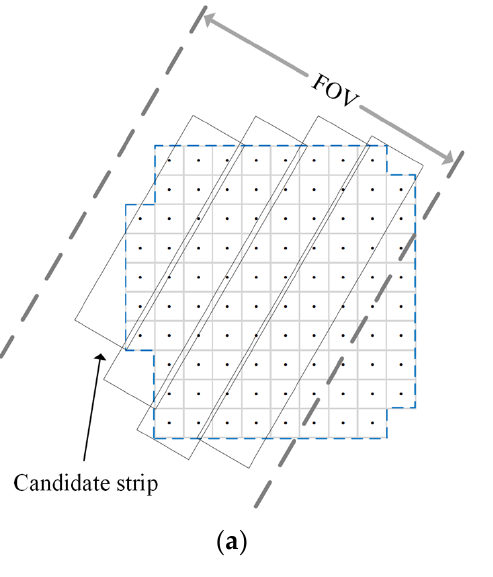
Figure 6. Two modes to generate candidate strip. ( a ) Parallel split; ( b ) grid split proposed in this paper.